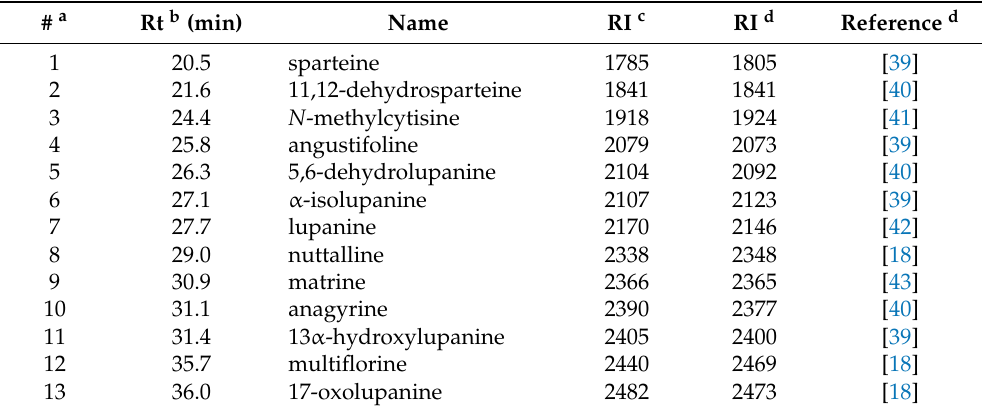
Table 1. Identified quinolizidines ( 1 – 13 ) in eight lupin species propagated under greenhouse condi-